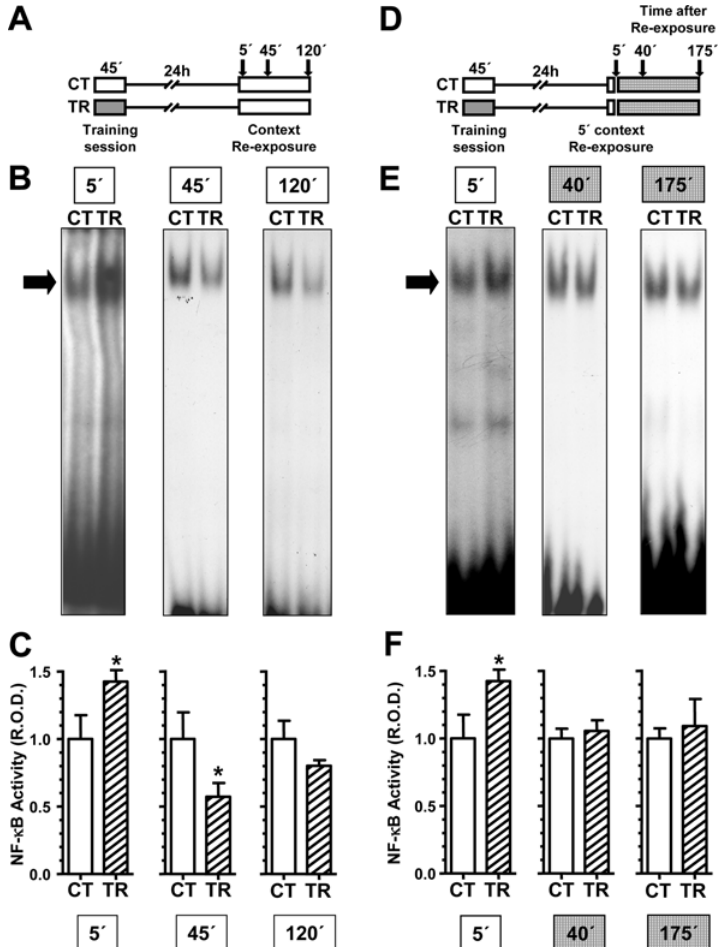
Figure 5. NF- k B activity during extinction session. A. Top diagram: experimental design. On day 1 the animals were trained with 15 trials (TR groups) or were located in the training apparatus but remained untrained (CT groups). On day two, the CT-TR groups were re-exposed to the training context. At different time points (indicated by arrows), animals of CT and TR pair of groups were anesthetized and nuclear extracts from the 20 central brains of each group were obtained. B. Representative EMSAs performed with nuclear extracts obtained from CT and TR groups at 5, 45 and 120 minutes of context re-exposure. The specific band is indicated with a filled arrow. C. NF- k B activity in TR group relative to CT. Mean 6 SEM of relative optic density (ROD) values of the specific NF- k B retarded band normalized to CT group media, obtained in four independent experiments. D, E and F. NF- k B activity after memory reactivation. D. Top diagram: experimental design. On day 1 the animals were trained with 15 trials (TR groups) or were located in the training apparatus but remained untrained (CT groups). On day two, the CT-TR groups were re-exposed for 5 minutes to the training context. At different time points after the re-exposure (indicated by arrows), animals of CT and TR pair of groups were anesthetized and nuclear extracts from the 20 central brains of each group were obtained. E. Representative EMSAs performed with nuclear extracts obtained from CT and TR groups at 5, 45 and 180 minutes after context re-exposure. The specific band is indicated with a filled arrow. F. NF- k B activity in TR group relative to CT. Mean 6 SEM of relative optic density (ROD) values of the specific NF- k B retarded band normalized to CT group media, obtained in four independent experiments. *, p , 0.05 in t- test.